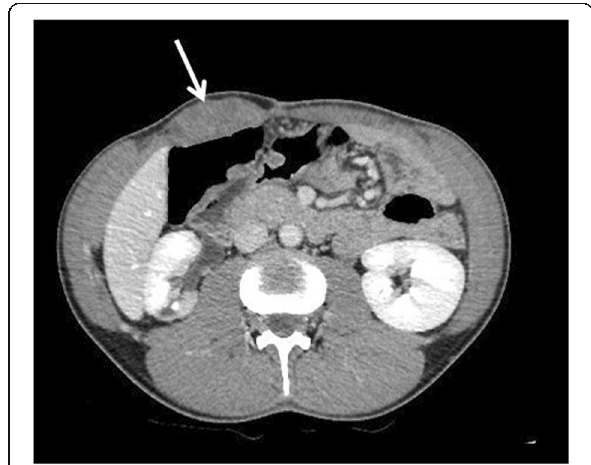
Fig. 14 CT appearance of an abdominal wall DT (arrow) in a 26- year-old male patient affected by Gardner syndrome with previous total